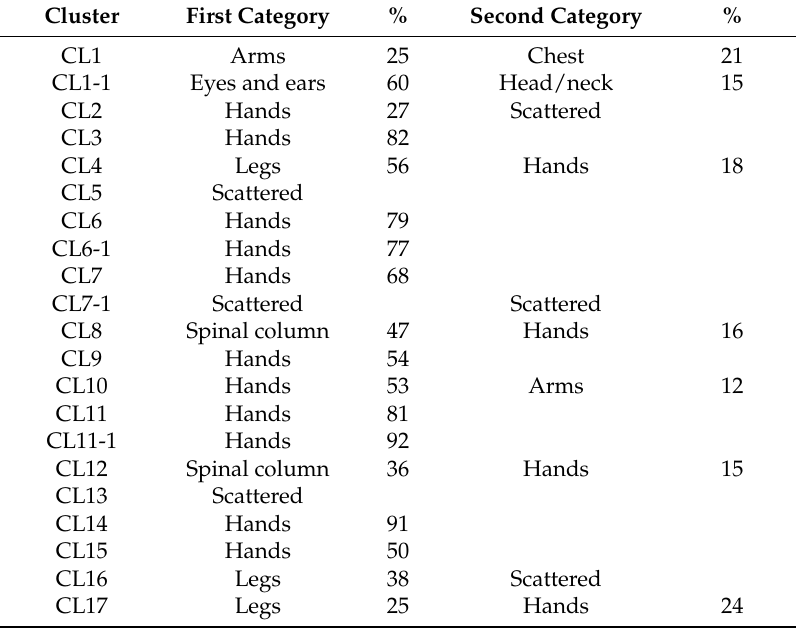
Table A6. Clusters description (Injured body part).